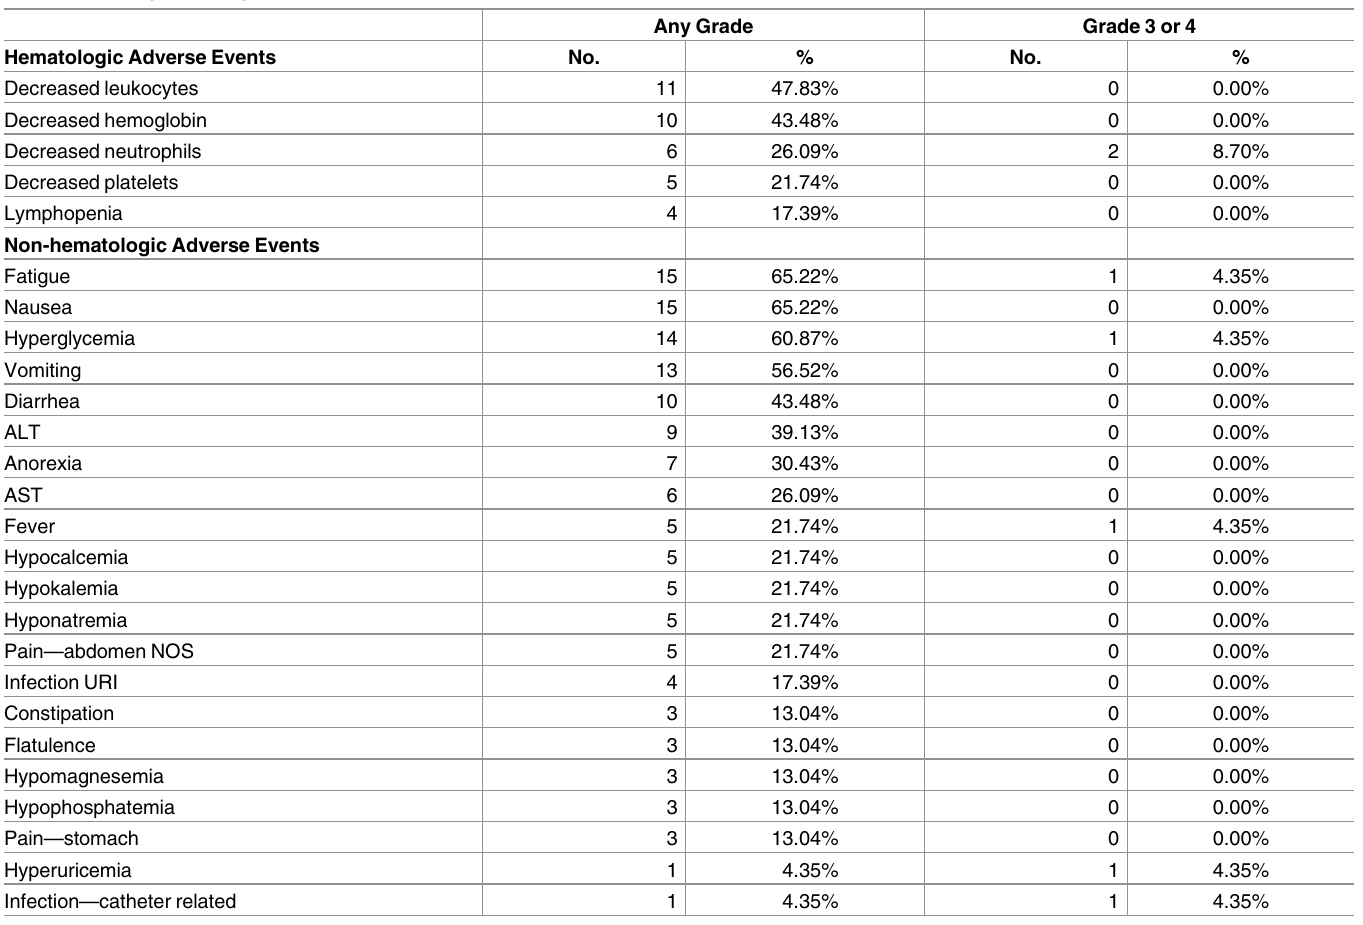
Table 7. Toxicity summary.